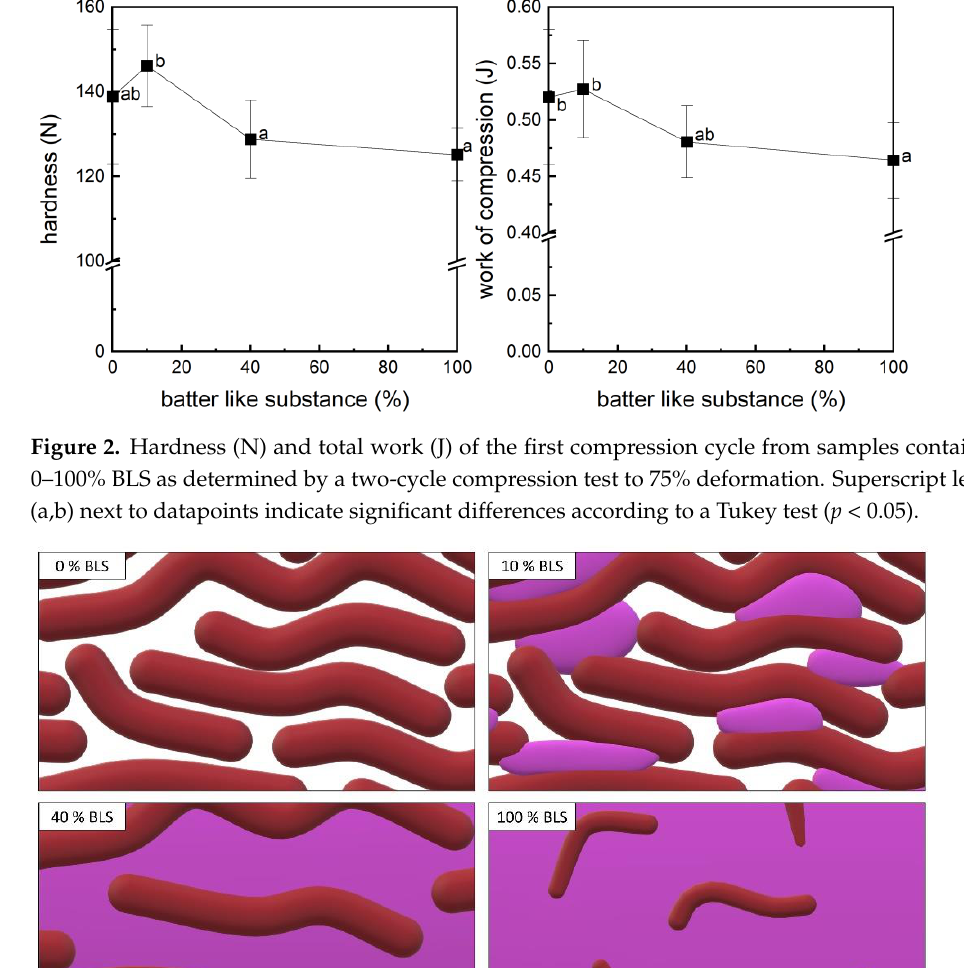
Figure 2. Hardness (N) and total work (J) of the first compression cycle from samples containing 0 – 100% BLS as determined by a two-cycle compression test to 75% deformation. Superscript let-